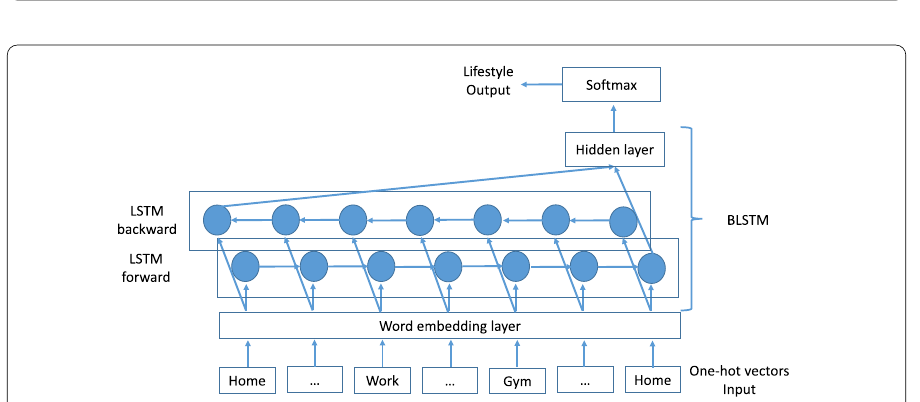
Figure 6 Predicting with LSTM. The LSTM model for predicting a lifestyle to trajectory. A one-hot vector has zeros for all trajectories except the specific trajectory (which is one)